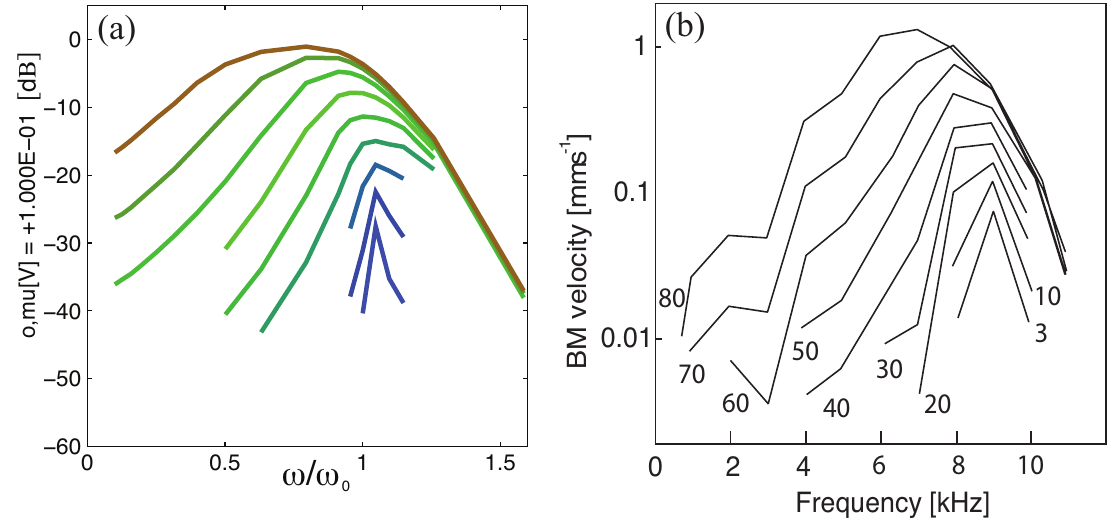
Figure 5. (a) Original measurements (2004) from a cochlea with directly implemented Hopf amplifier outer hair cells, reproduced in [21]. Input stimulation range: 80 dB. For more refined measurements and more complete information see, e.g., [22,23] and, most recently, [24]. (b) Chinchilla cochlea [25]. To be compared with Figure 6(a) from